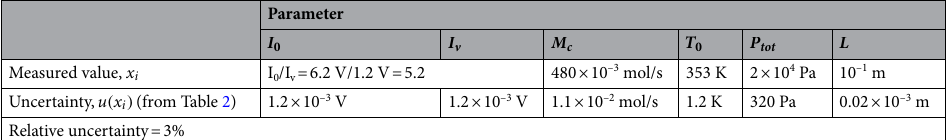
Table 5. Relative uncertainty in lasing specie (iodine) measurement.